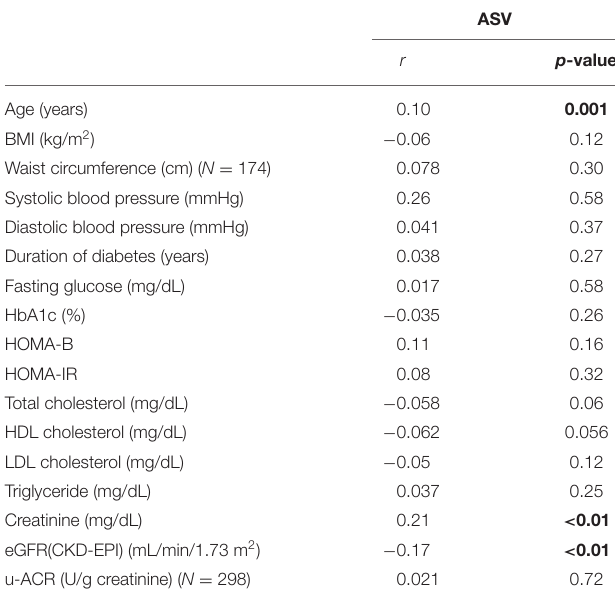
TABLE 2 | Correlation between uric acid variability and other